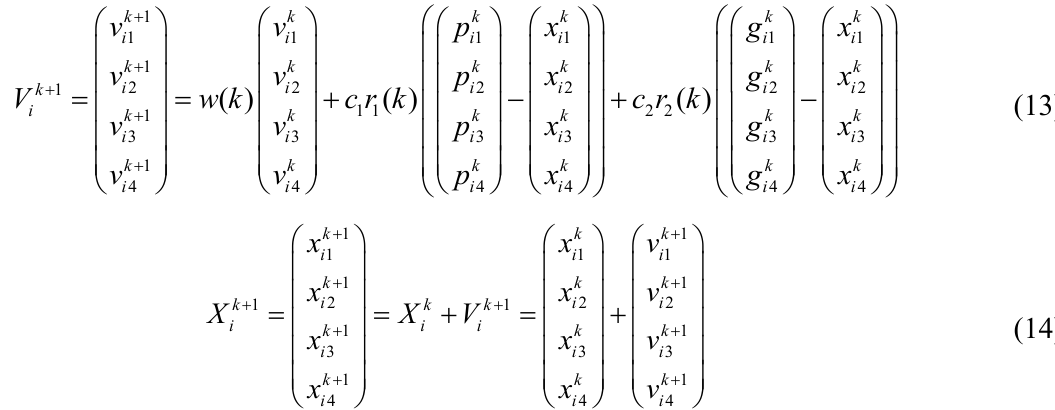
Table 2. Operation program flowchart of PSO